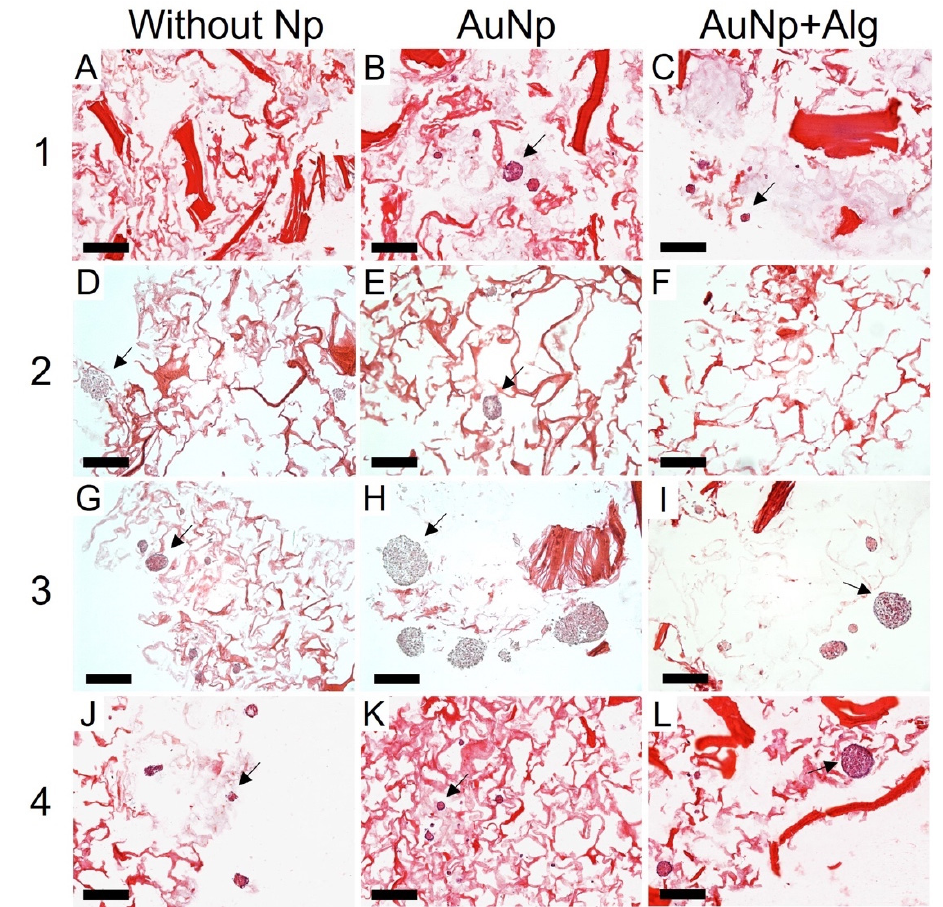
Figure 6. Representative photomicrographs of cross sections of the constructs. Method 1: ( A ) without Np, ( B ) AuNp and ( C ) AuNp+Alg. Method 2: ( D ) without Np, ( E ) AuNp, and ( F ) AuNp+Alg. Method 3: ( G ) without Np, ( H ) AuNp and ( I ) AuNp+Alg. Method 4: ( J ) without Np, ( K ) AuNp and ( L ) AuNp+Alg. H&E. Identifier: arrow (spheroids). Scale bar: 200 µm, original magnification: ×100.